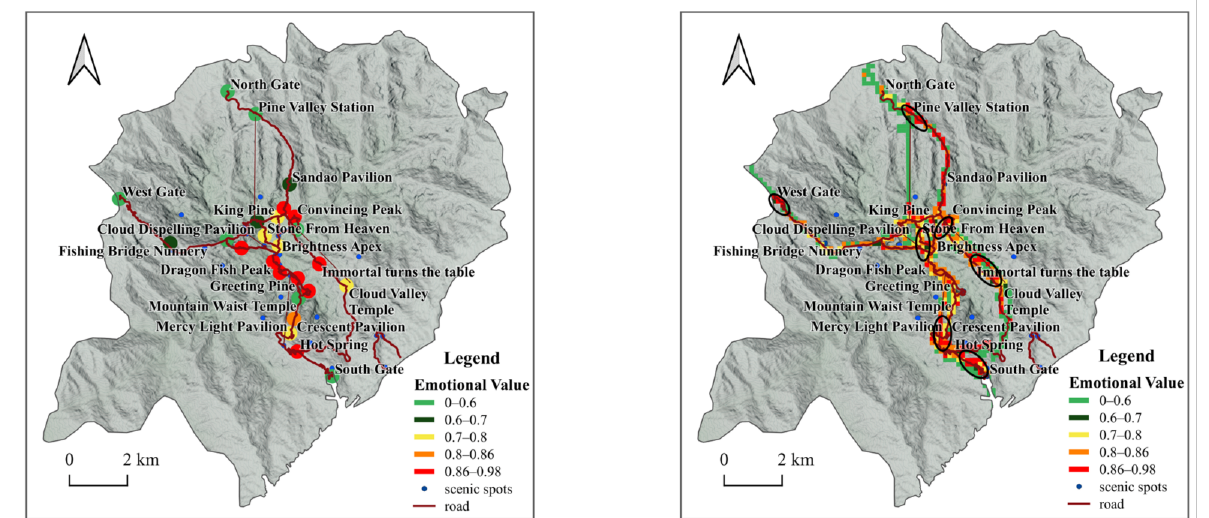
Figure 9. Emotional value of tourists’ photos on a scale of scenic spots and